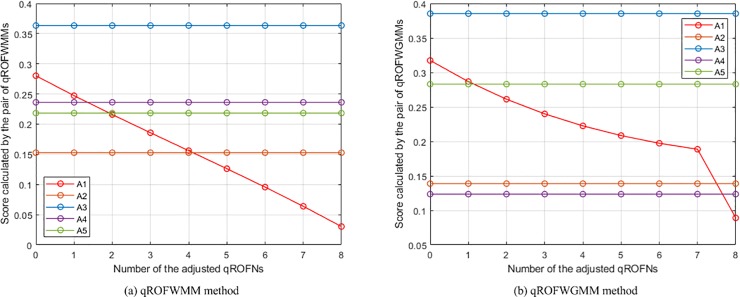
The changes of the places of A1 in the rankings of the WMM and WGMM methods.